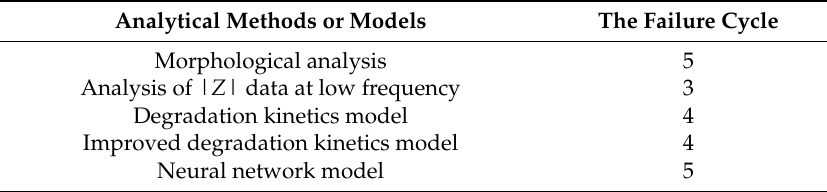
Table 4. The failure cycle determined by different analytical methods and